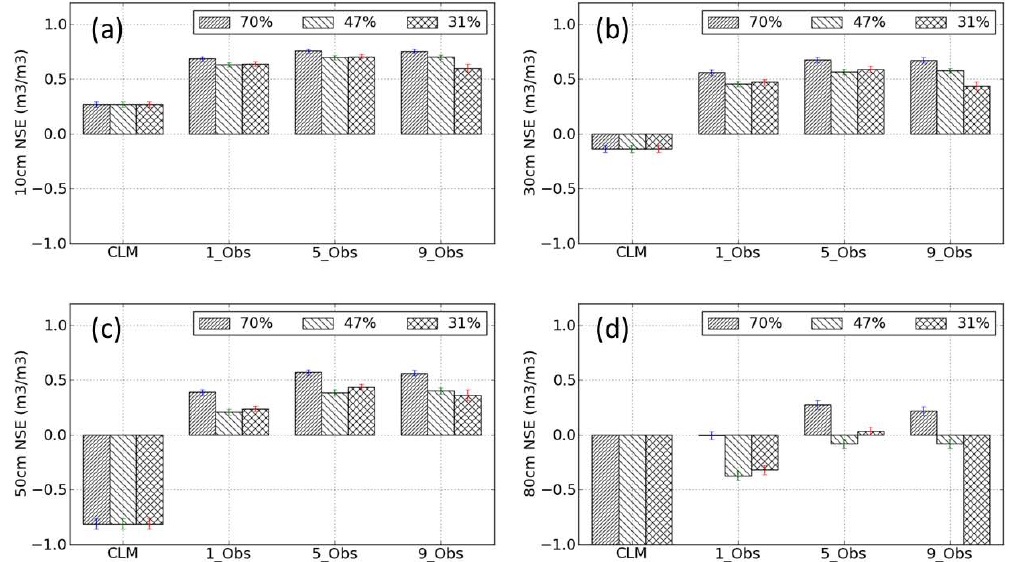
Fig. 8. This figure shows the mean basin scale soil moisture NSE values (including 95% confidence intervals) for open loop simulations (CLM) and three assimilation strategies of 1 observation used (1 Obs), 5 observations used (5 Obs), 9 observations used (9 Obs) at all grid cells for 10cm (a) , 30cm (b) , 50cm (c) and 80cm (d) depth and 70%, 47% and 31% observational